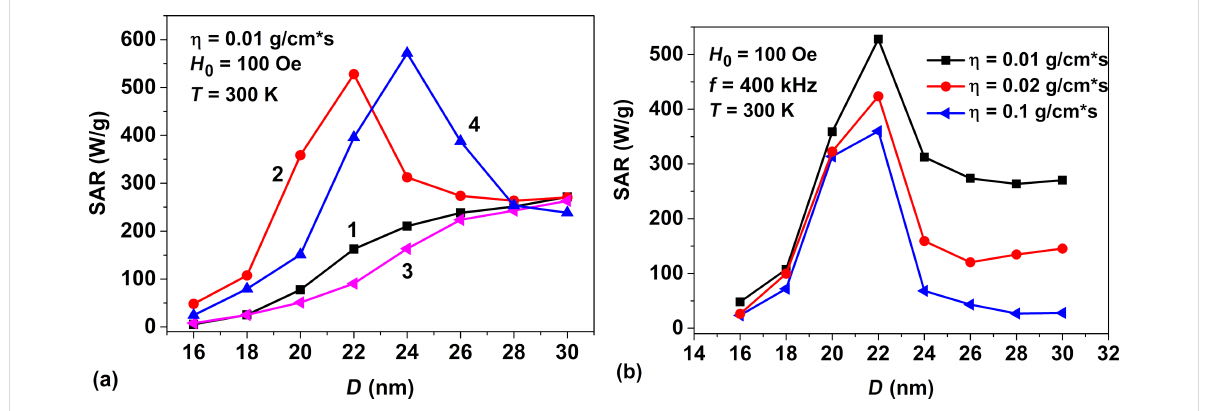
Figure 5: a) SAR in RMFs for dilute assemblies of superparamagnetic nanoparticles with various magnetic anisotropy constants: 1) K = 10 5 erg/cm 3 , f = 100 kHz, 2) K = 10 5 erg/cm 3 , f = 400 kHz, 3) K = 8 × 10 4 erg/cm 3 , f = 100 kHz, 4) K = 8 × 10 4 erg/cm 3 , f = 400 kHz. b) SAR of assemblies of superparamagnetic nanoparticles depending on the viscosity of the liquid.